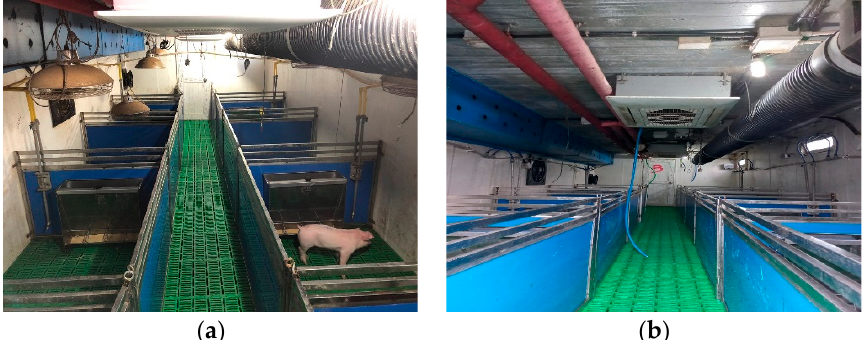
Figure 1. Inside pictures of pig houses used in this study. ( a ) Control house with heating lamps of adjustable height. ( b ) Pig house installed with GHPS heating